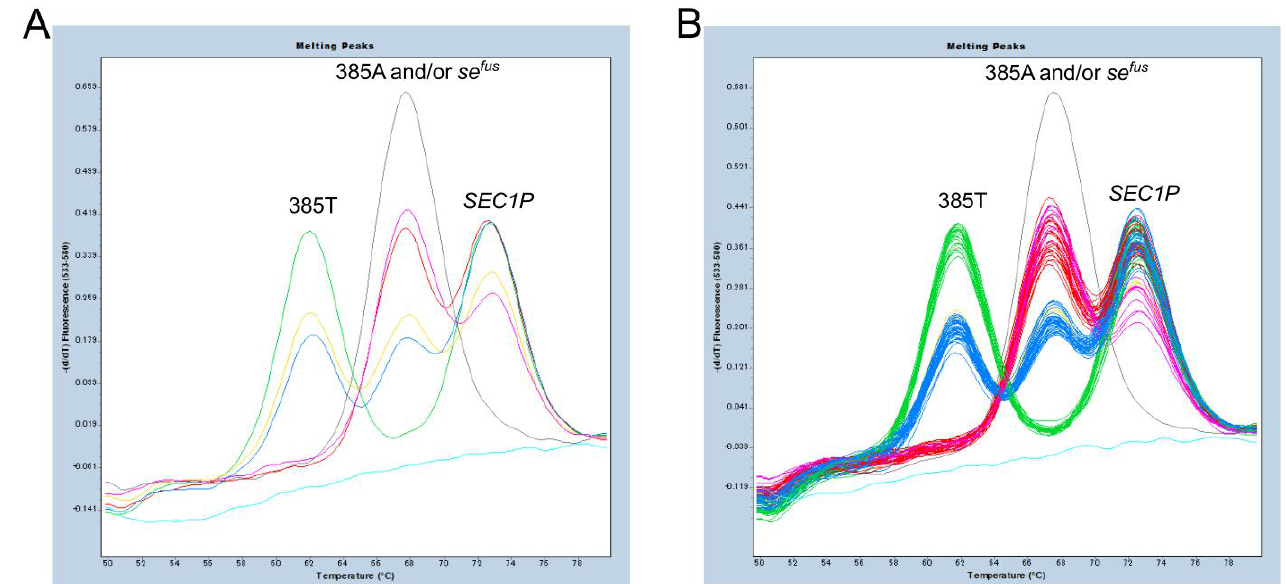
Figure 2. Melting peak profiles of FMCA for detection of c.385A>T and se fus . Six Japanese ( A ) and 96 Japanese subjects ( B ) whose FUT2 genotypes were already determined were selected. The subjects with genotypes 385A/A (red), 385T/T (green), se fus / se fus (gray), 385A/T (blue), 385A/ se fus (pink), and 385T/ se fus (yellow) were clearly identified. The negative control is shown in light blue.